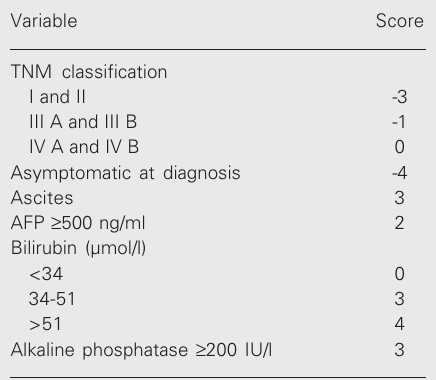
Table 5. Chinese University Prognostic Index (CUPI) classification of hepatocellular carcinomas